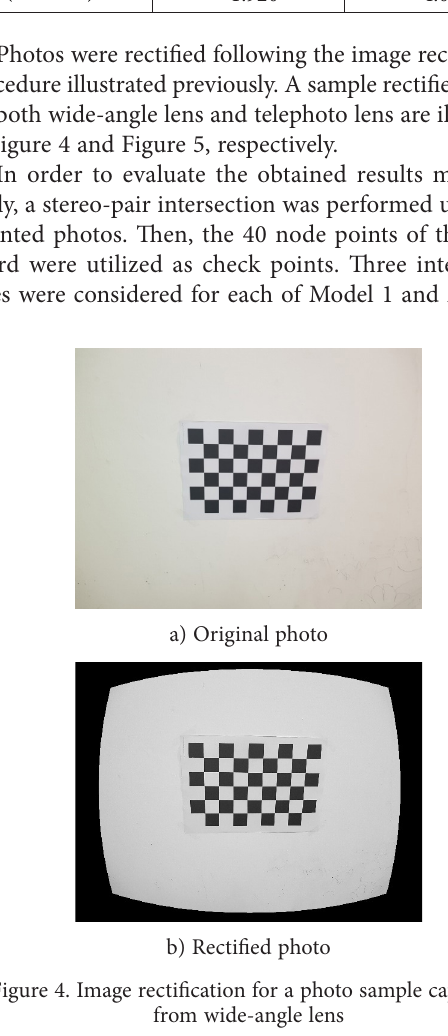
Table 2. Intrinsic parameters and radial lens coefficients for